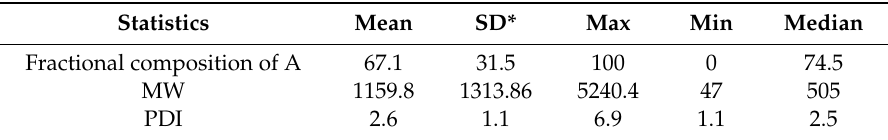
Figure 9. The statistical distribution of the input data. ( a ) Fractional composition of A; ( b ) molecular weight; ( c ) PDI. Table 4. The descriptive statistics of the input data.